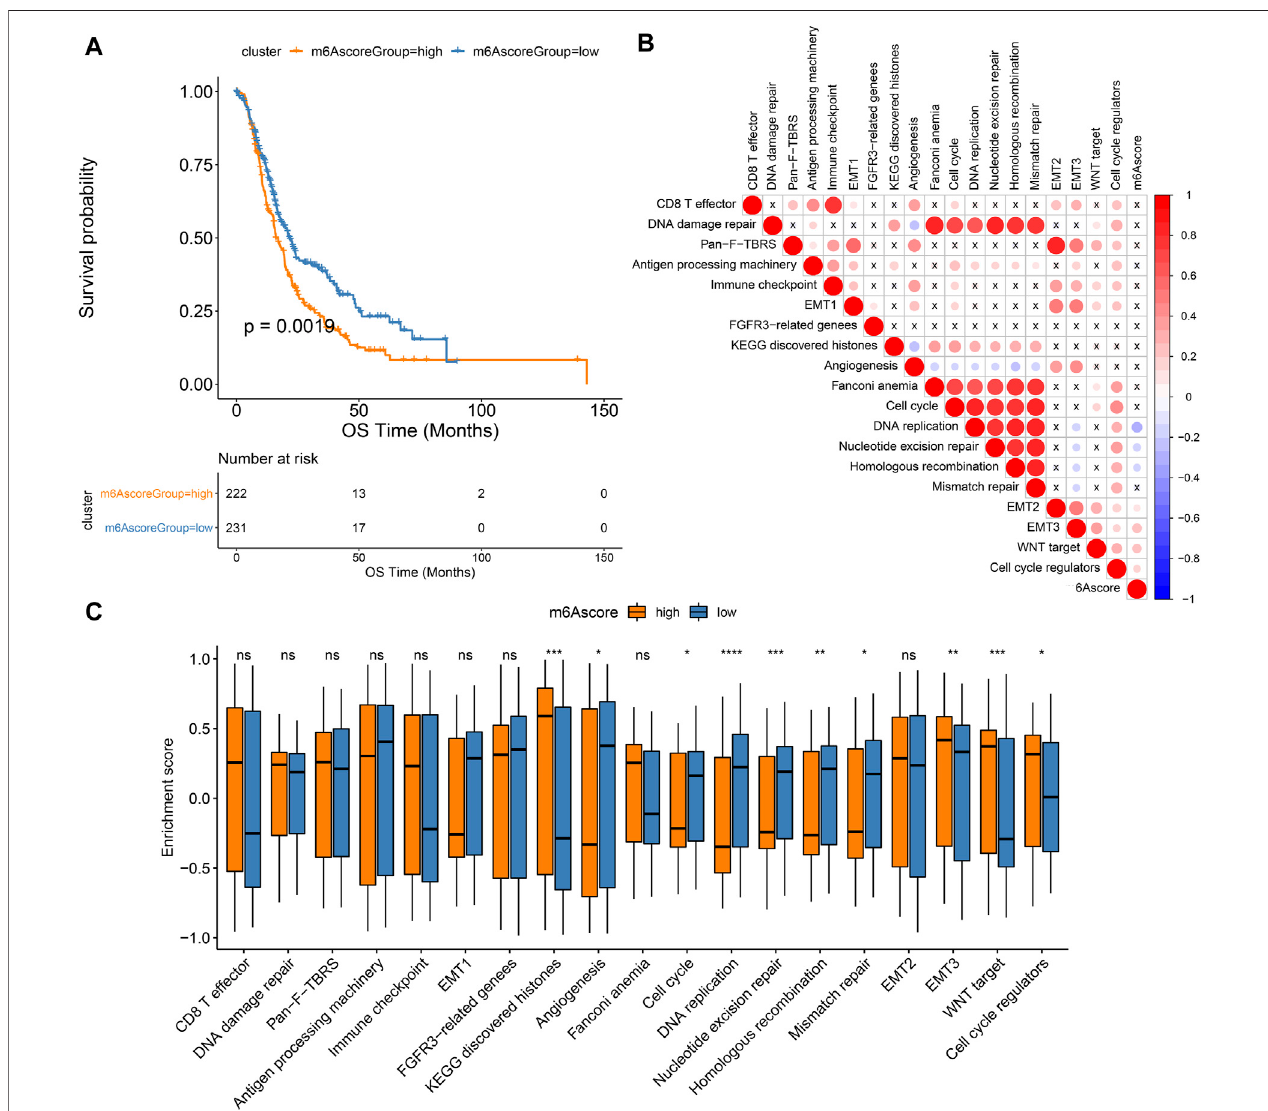
FIGURE 6 | Associations between m 6 A scores and pancreatic cancer prognoses. (A) Kaplan-Meier curves of patients with high and low m 6 A scores. (B) Correlationbetweenkeybiologicalprocesses and m 6 Ascores. (C) Boxplotoftheenrichmentscoresofkeybiologicalprocesses inhigh and lowm 6 Ascoregroups. Ns: not signi fi cant; * p < 0.05; ** p < 0.01; *** p < 0.001; **** p <